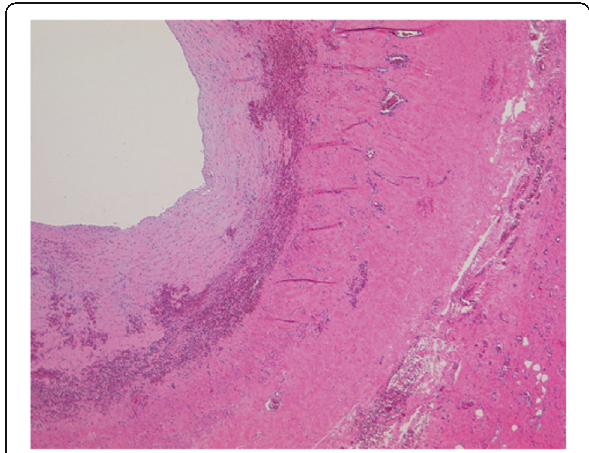
Fig. 3 The histological findings showed that the wall of the cystic mass had hyaline degeneration and the endothelium was not